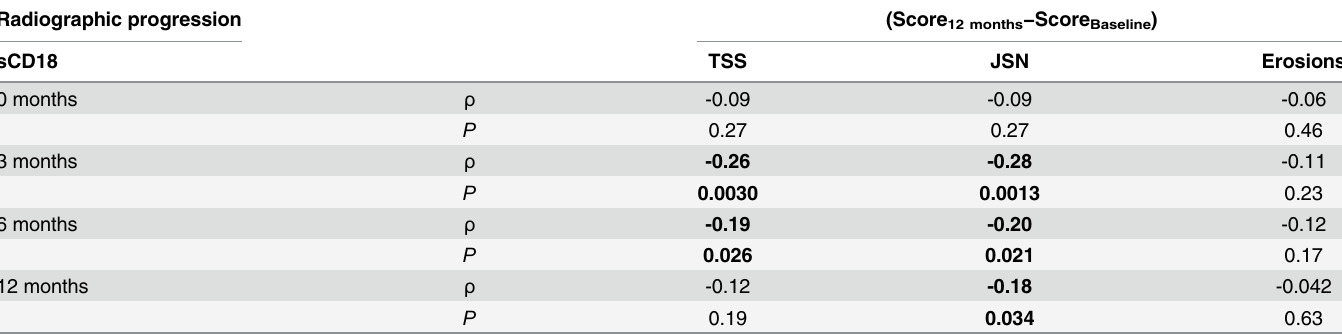
Table 2. Correlations of sCD18 with radiographic progression. Radiographic progression